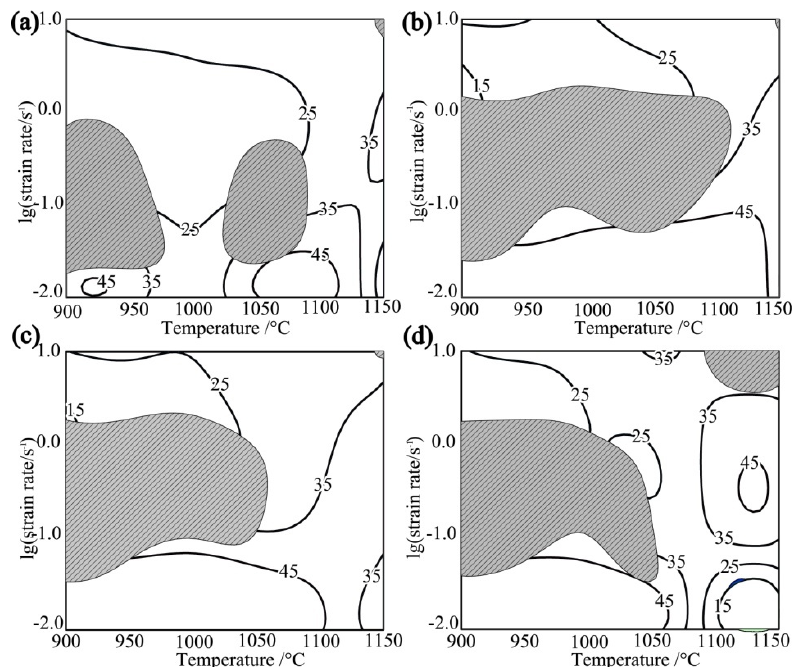
Figure 9. Hot working maps of 300M steel at the strain of ( a ) 0.2, ( b ) 0.4, ( c ) 0.6, and ( d ) 0.8.